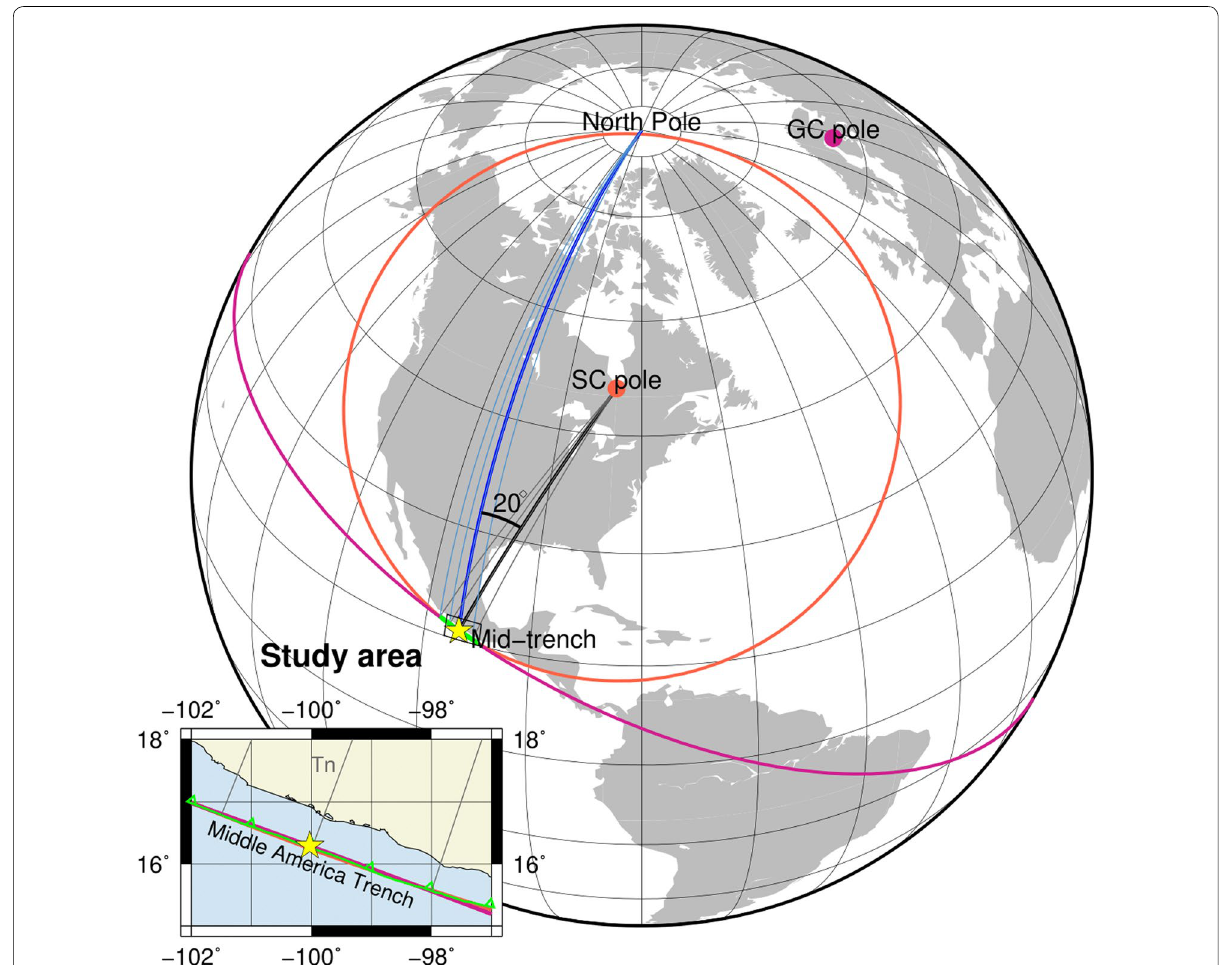
Fig. 2 Trench approximation. Great (GC) and small (SC) circles computed to approximate the trench section in Guerrero and Oaxaca. The SC approximation fits the MAT better. Blue line is the direction to the North, gray lines—trench normals ( T n